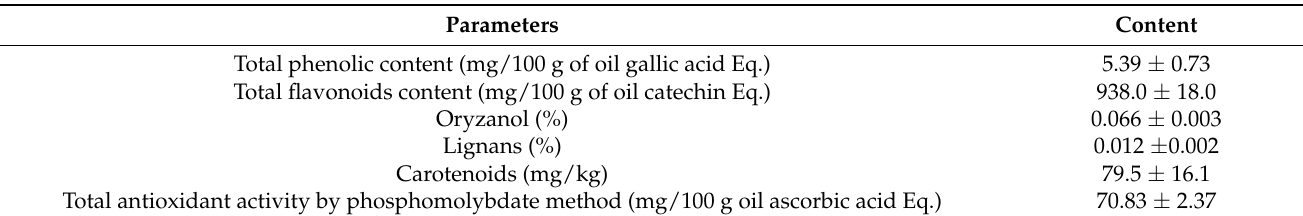
Table 3. The bioactive compound content and antioxidant activity of the Tumba ( Citrullus colocynthis L.) seed oil obtained in the present study.